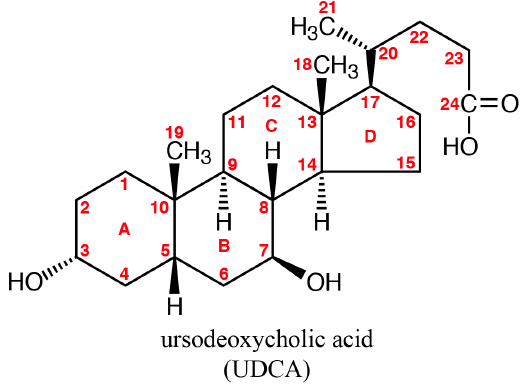
Figure 8. Structure of ursodeoxycholic acid (UDCA).